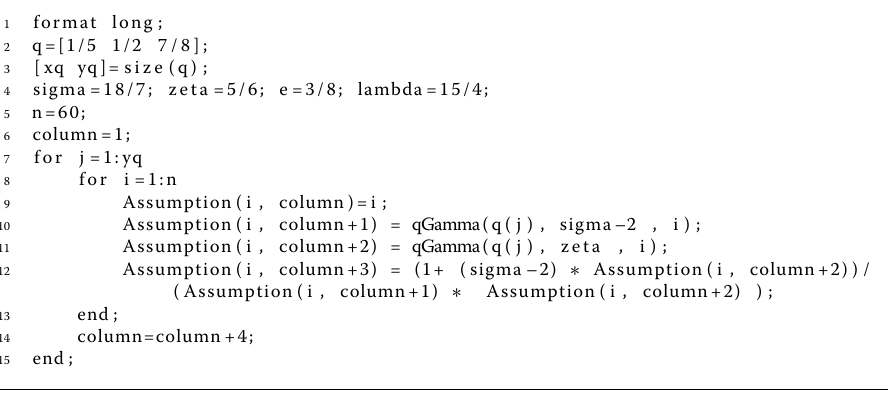
in Theorem 3.7 for q (cid:12) q ( σ –2) (cid:12) q ( ζ )